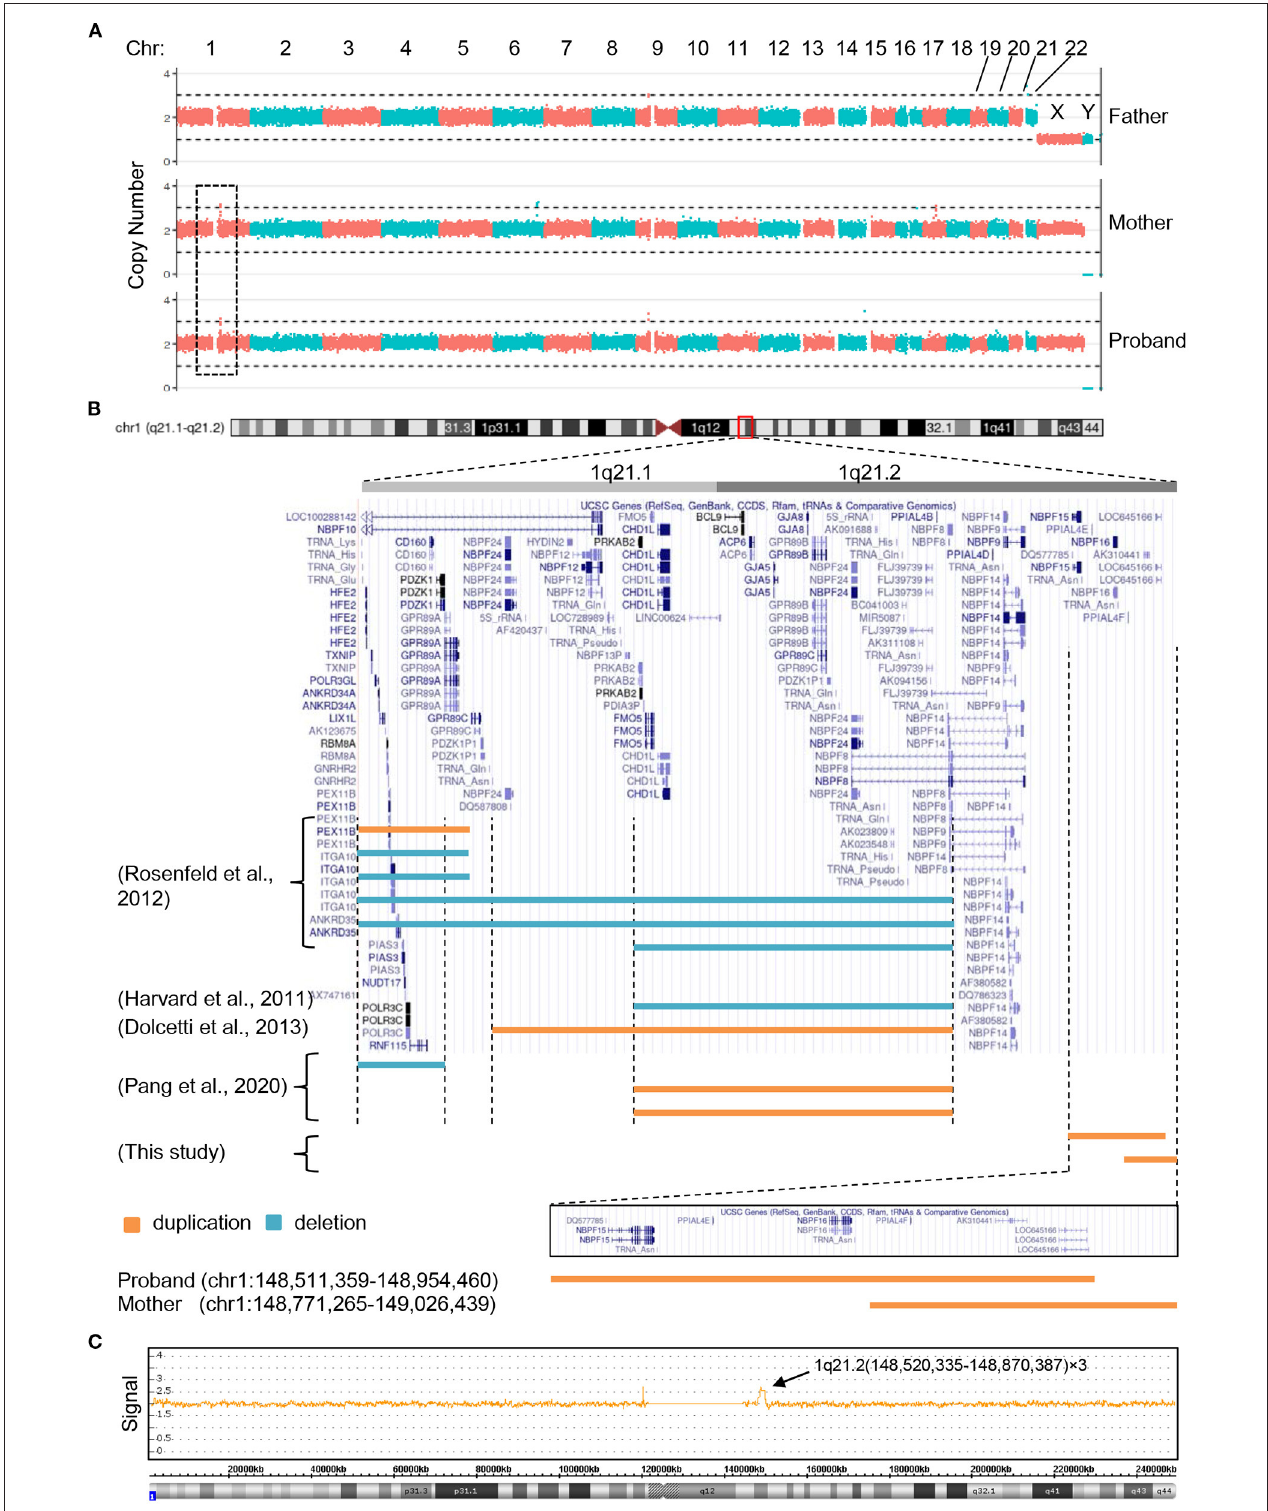
FIGURE 2 | The 1q21 microduplications or microdeletions of the proband, her mother and other reported patients with hearing problem. (A) Copy number analysis of the proband and her parents by next generation sequencing. (B) Positional plots of the microduplications and microdeletions on 1q21.1 and 1q21.2 regions (http:// genome.ucsc.edu). (C) Confirmation of the proband’s microduplication by CytoScan HD